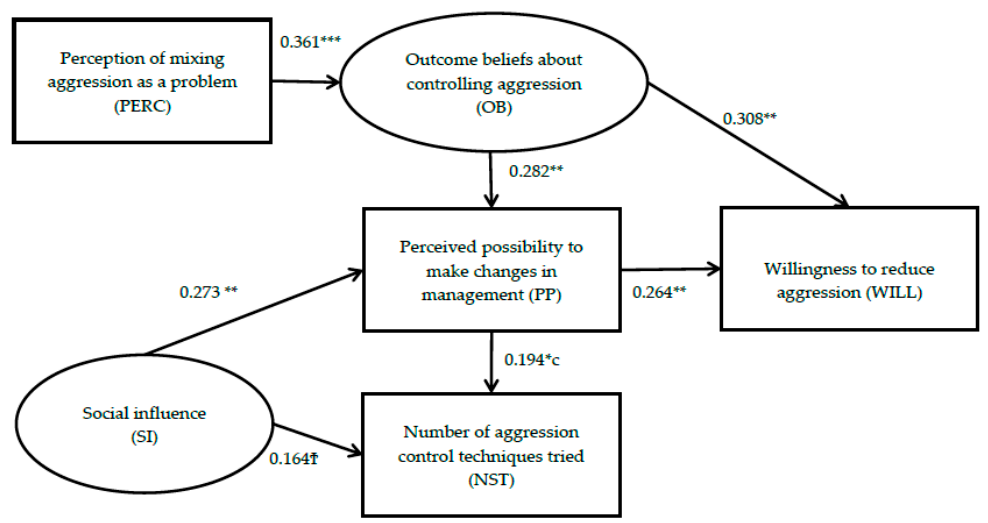
Figure 3. Path diagram of standardized parameters, whereby; Ϯ p < 0.1, * p < 0.05, ** p < 0.01, *** p < 0.001. Latent variables are represented by ovals and observed variables by rectangles. All possible relationships between observed and latent variables were estimated and only relationships whereby p < 0.10 are displayed. Regression coefficients are presented for each relationship.